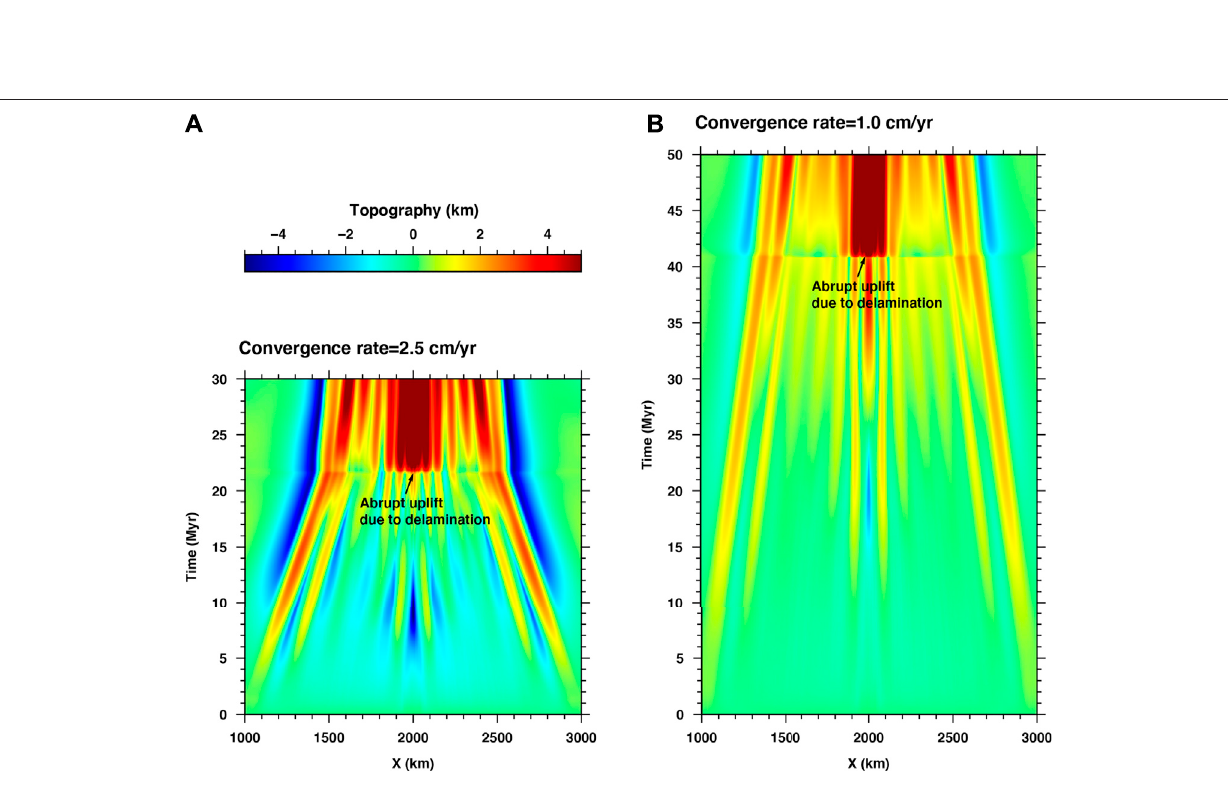
Frontiers in Earth Science |